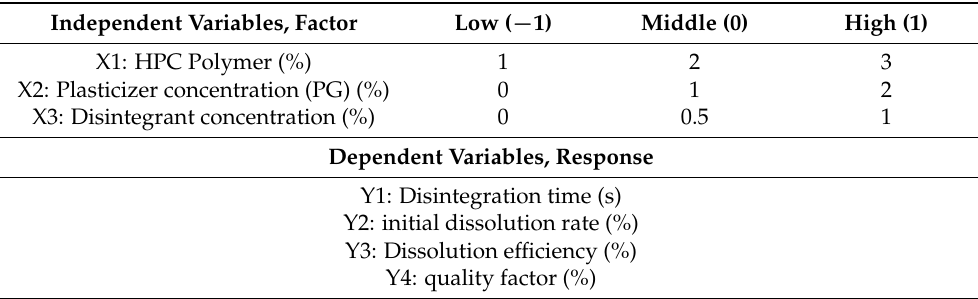
Table 2. Variables in Box-Behnken design for FLBFDOFs.